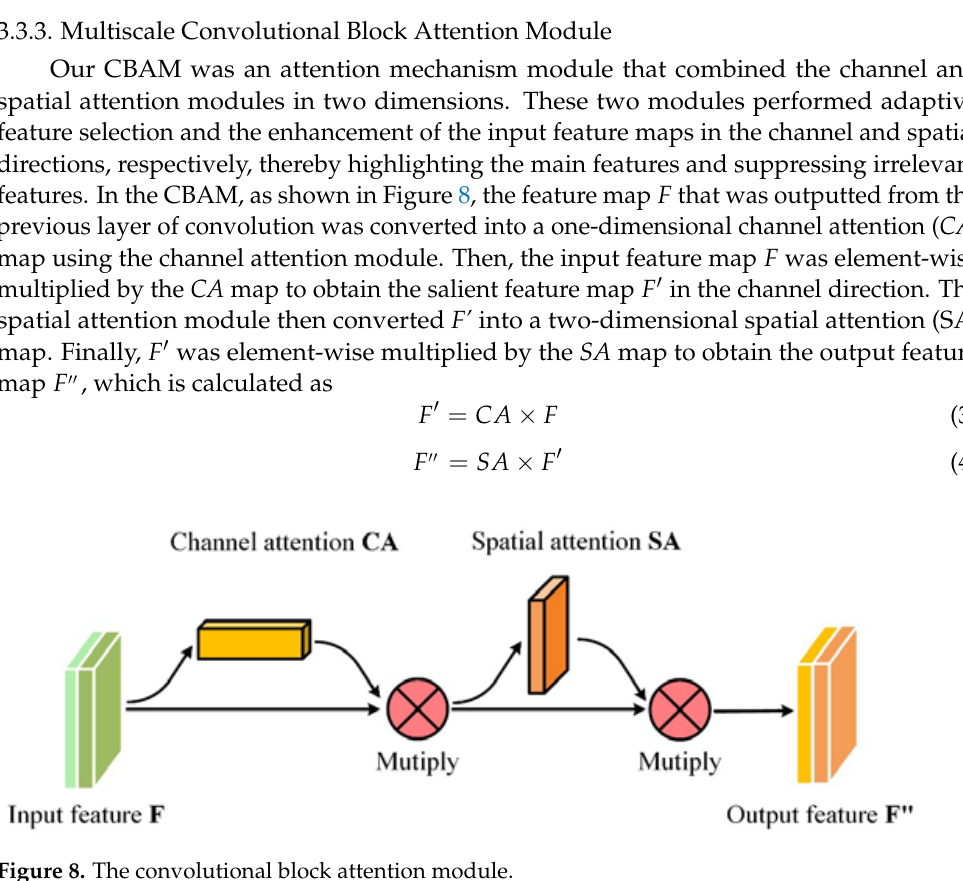
Figure 8. The convolutional block attention module.